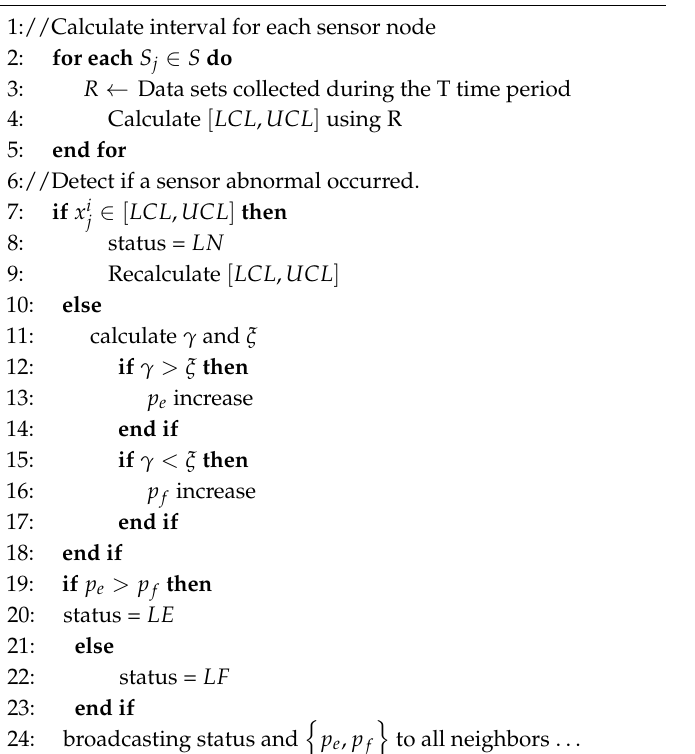
Algorithm 1. Temporal